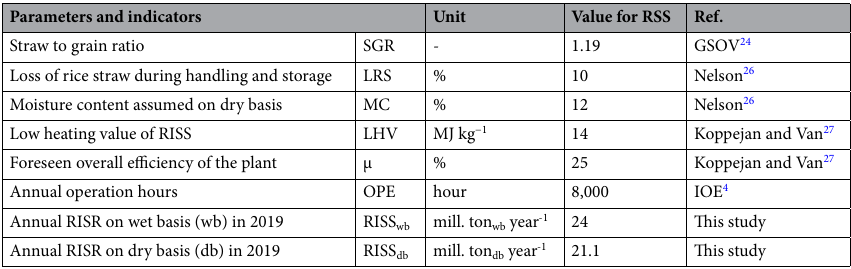
Table 1. Parameters adopted to estimate the rice straw surplus energy potential.